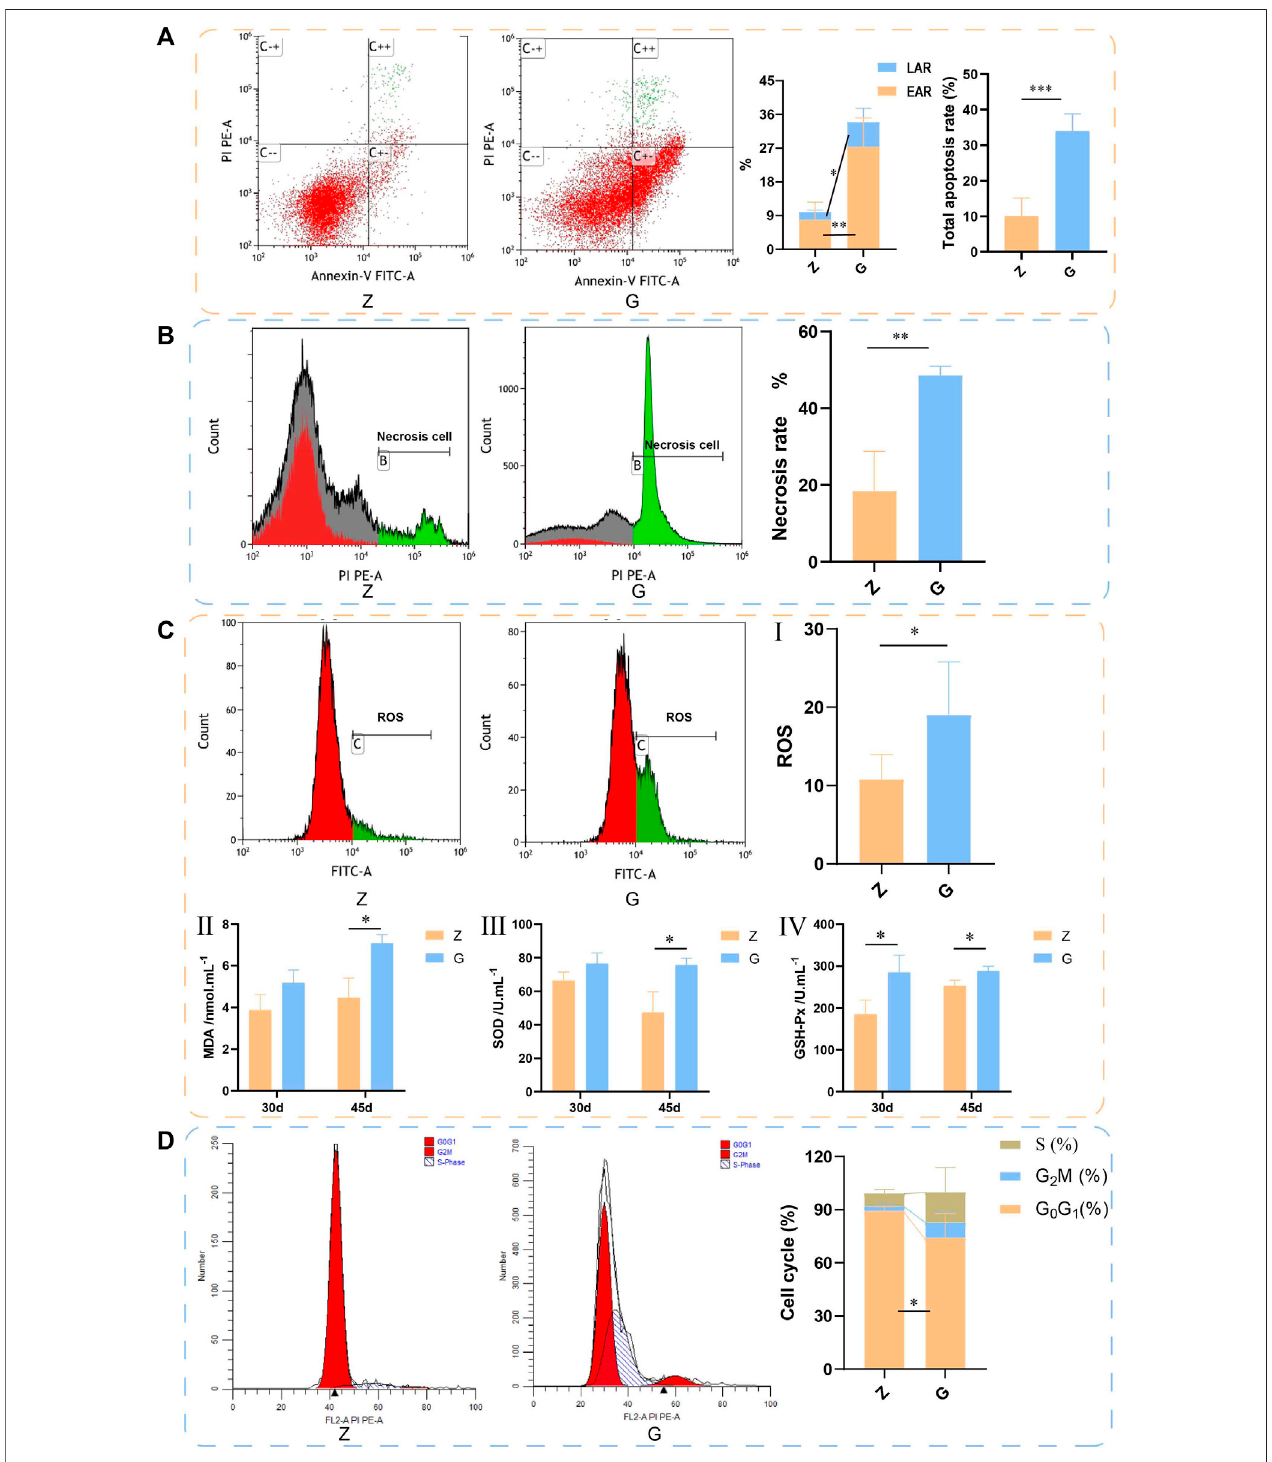
FIGURE 5 | The livers of largemouth bass fed with 45 days by fl ow cytometry assay. (A) Apoptosis detected by fl ow cytometry. Annexin-V binds to phosphatidylserine on the surface of cells to detect early apoptosis. PI is a DNA dye that enters the nucleus and binds to DNA to indicate late apoptosis. C −− : live cells; C+ − :earlyapoptoticcells;C++lateapoptoticcells;C − +:mechanicallydamagedcells.LAR:earlyapoptosisrate,EAR:lateapoptosisrate. (B) Necrosisdetectedby fl ow cytometry. (C) ROS detected by fl ow cytometry. (II – IV) Detection of serum MDA, SOD, and GSH-Px. (D) Cell cycle detected by fl ow cytometry (* p < 0.05, ** p < 0.01, and *** p < 0.001).